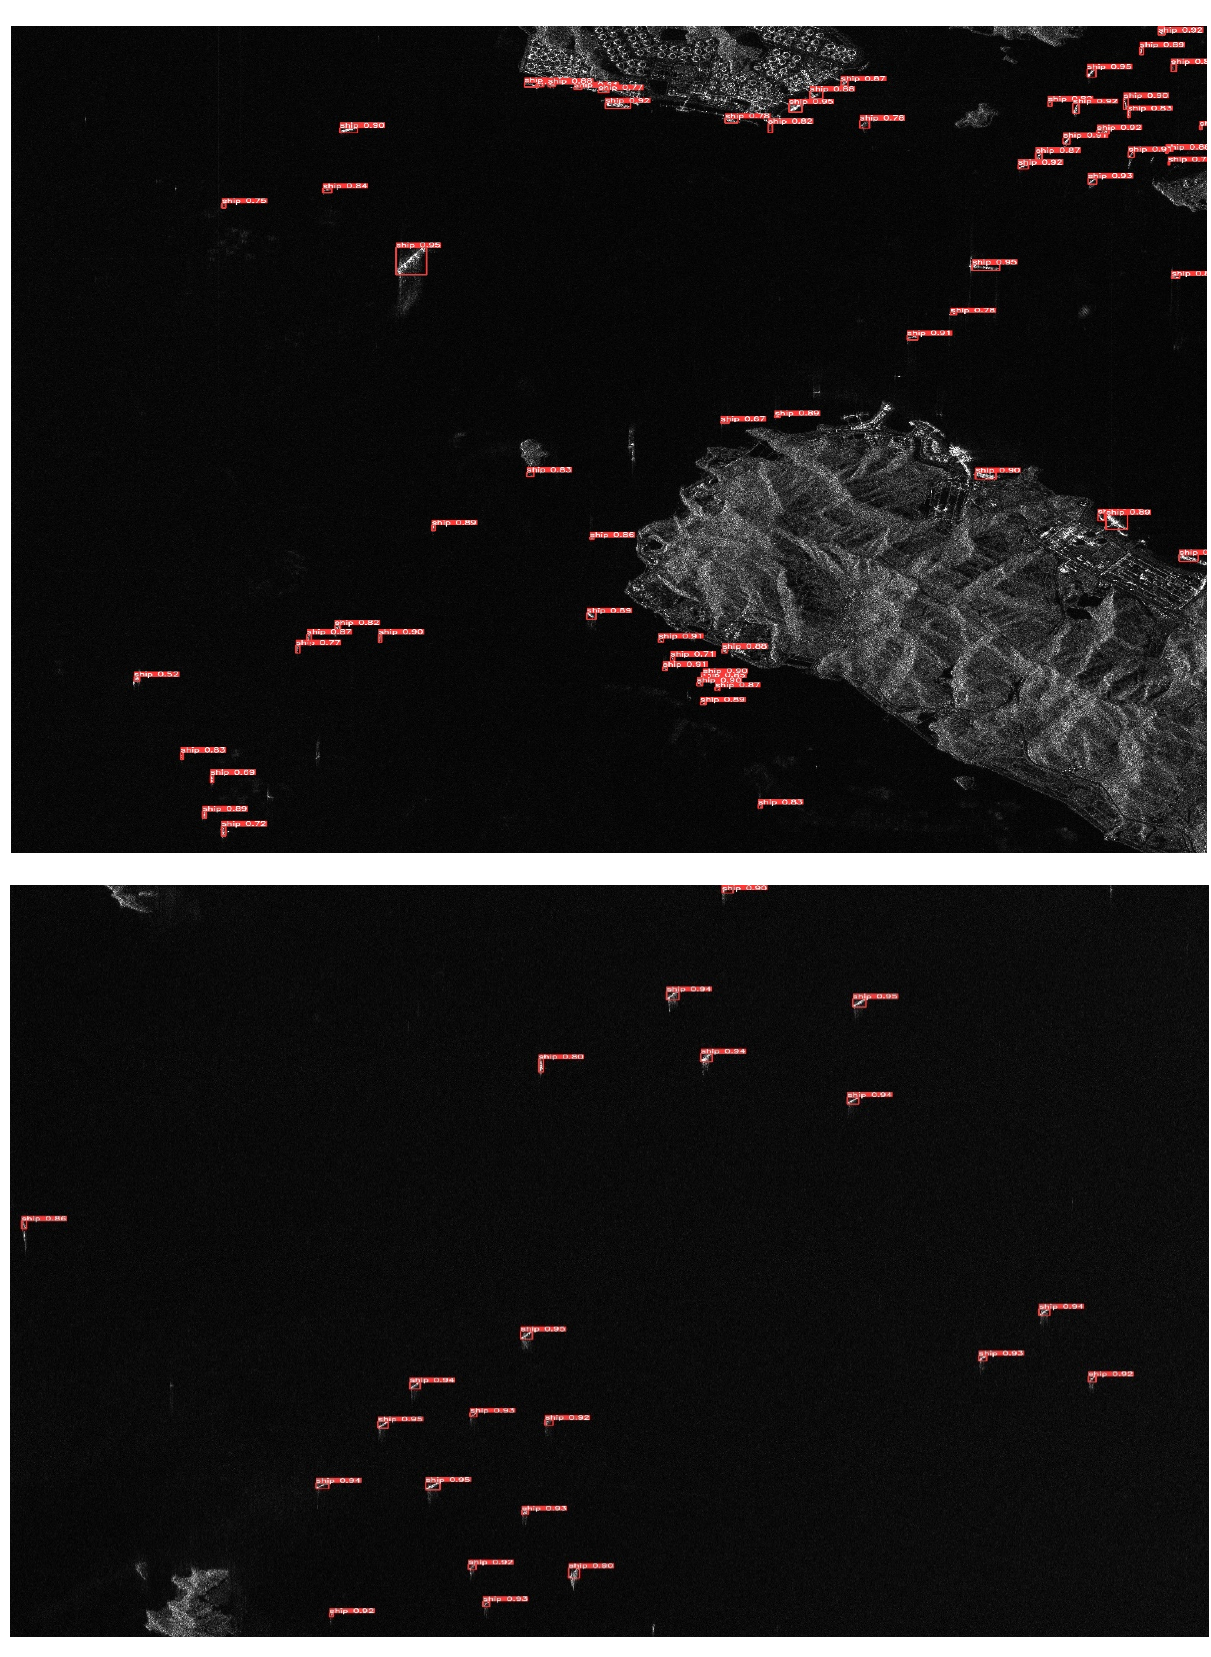
Figure 13. Detection results in large-scale SAR images. Both images are 4000 pixels × 4000 pixels.